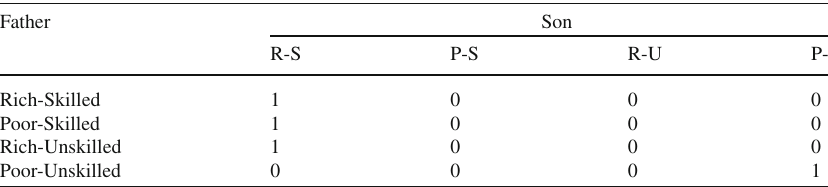
> (cid:12) b 0 , and then they will remain as educated 0